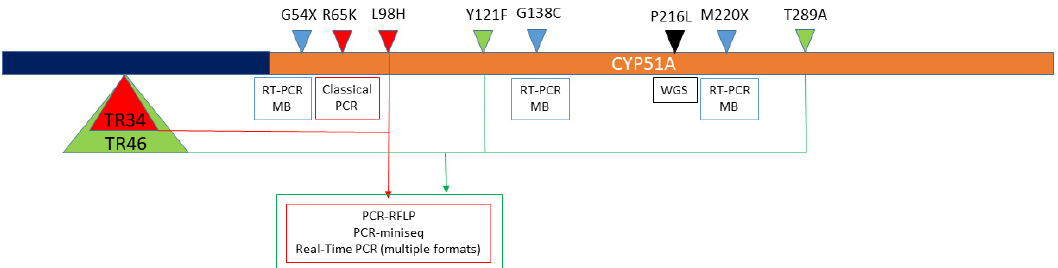
Figure 3. Mutations in A. fumigatus cyp51A (brown bar) and its promoter (5 ´ UTR) region (dark blue bar) detected by the available molecular methods. Boxes indicate the molecular methods used to detect the mechanisms that are over them. Arrow heads represent the mutations linked with triazole resistance. Green and red arrow heads show the combined mechanisms that include CYP51A mutations together with promoter alterations described as tandem repetitions (TR). Light blue arrow and black heads represent single-nucleotide mutations detected by RT-PCR coupled with molecular beacons (RT-PCR MB) and whole-genome sequencing (WGS).